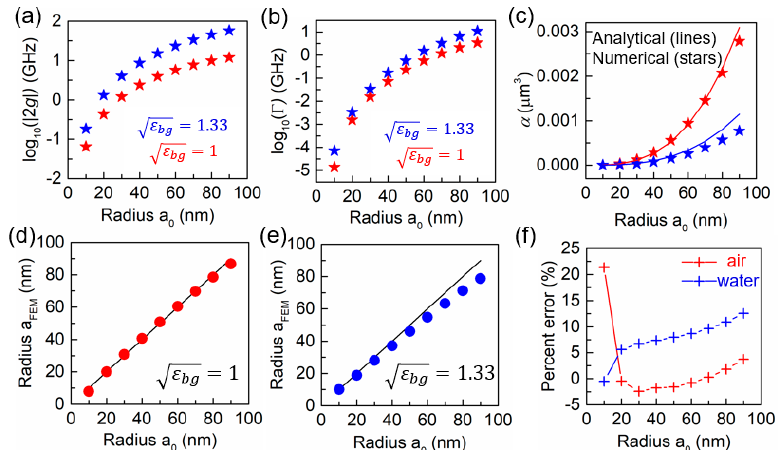
Figure 2. Three-dimensional eigenfrequency simulation results of ( a ) the splitting frequency | 2 g | and ( b ) linewidth broadening Γ versus radius a 0 in terms of two di ff erent background media: air with √ √ ε ε = 1 and water with = 1.33. ( c ) Nanosphere polarizability versus radius a . Solid lines bg bg denote the analytical calculation using Equation (1) and stars denote numerical results derived from √ (cid:16) (cid:17) Γ /2 g = − αω ε 3 / 3 6 π c 3 . ( d , e ) Particle radius a FEM derived from Equation (4). Solid lines c bg